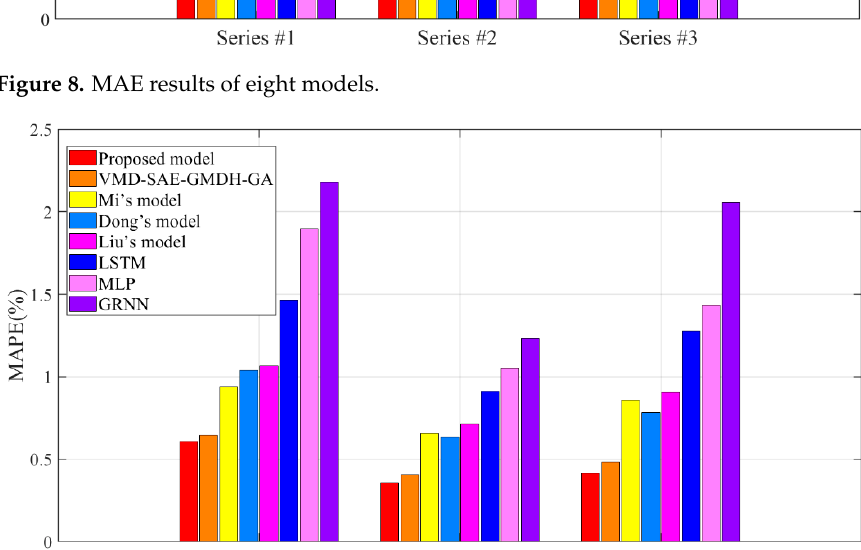
Figure 8. MAE results of eight models.